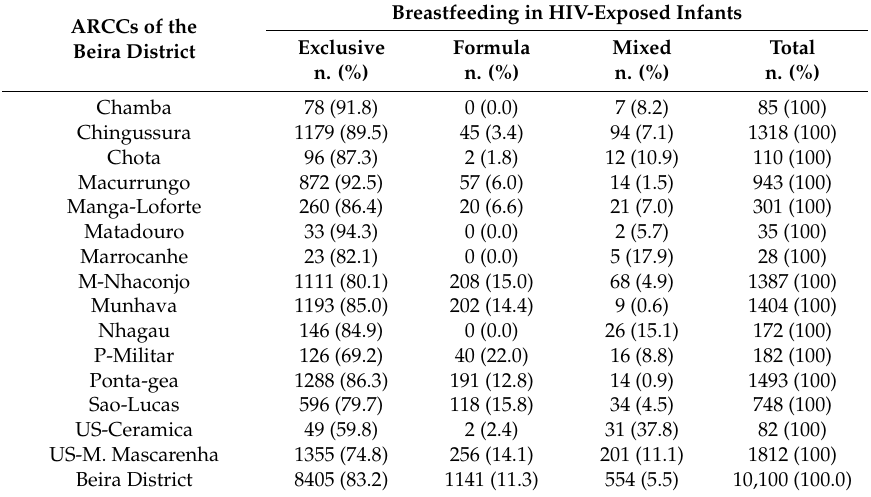
Table 3. Type of breastfeeding reported for n. 10,100 HIV Exposed Infants, assisted at the 15 ARCCs of the Beira District,